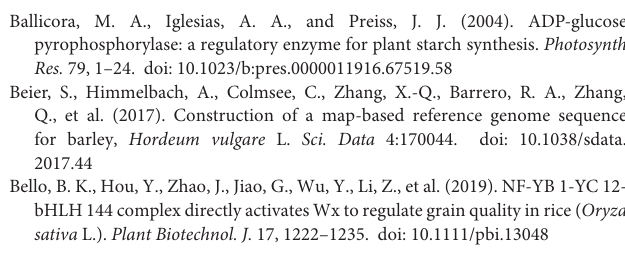
Supplementary Figure 1 | Sequence alignment of proteins from different subfamilies of the HvAP2/ERF family. Supplementary Figure 2 | Conserved motifs of the 185 HvAP2/ERF genes. Supplementary Figure 3 | Gene structures of 185 barley HvAP2/ERF genes with full-length coding